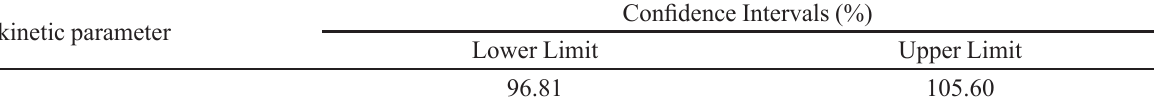
, after oral administration max